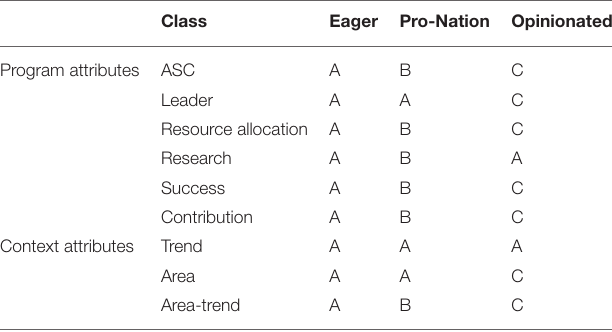
TABLE 5 | Definition of constraints for the 3-latent class model of the main urban resident’s sample ( n = 1,859). Class Eager Pro-Nation